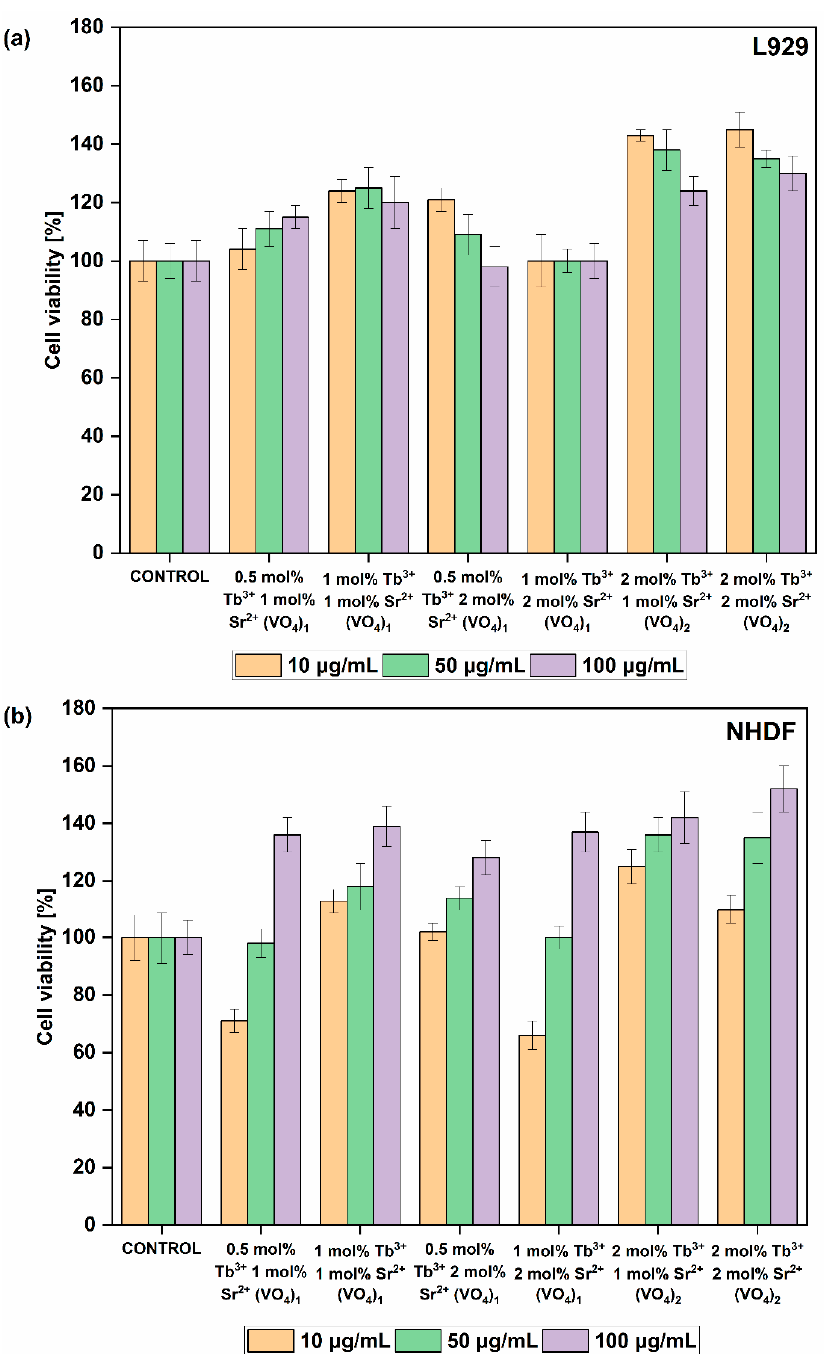
Figure 8. MTT cytotoxicity assay of phosphate–vanadate hydroxyapatite co-doped with Tb 3+ and Sr 2+ ions. The final concentrations of the tested compounds were established at 10 μ g/mL, 50 μ g/mL and 100 μ g/mL. Cell lines used in the experiment were ( a ) L929 and ( b ) NHDF cells.